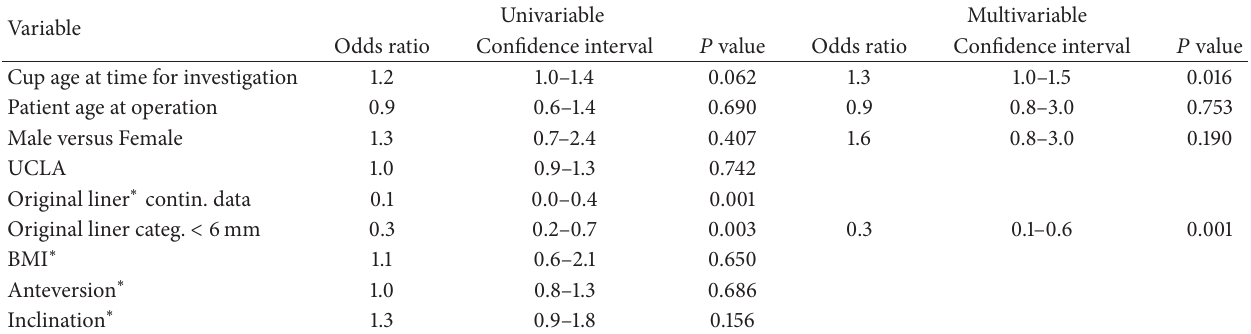
Table 5: Logistic regression model with wear as